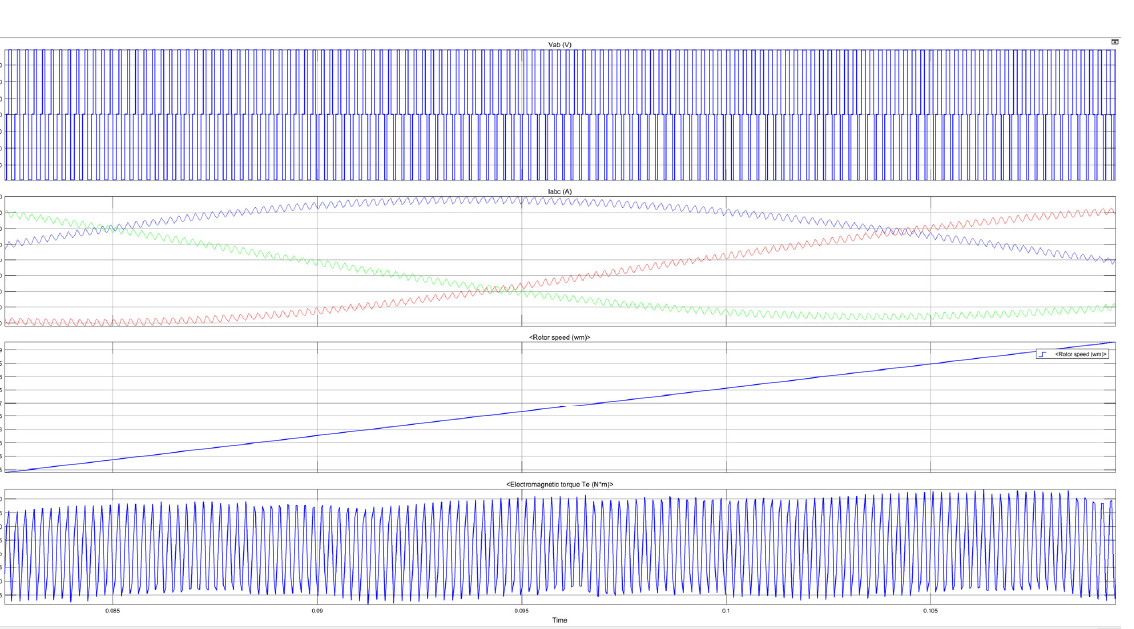
Table 1. Parameters of the induction motor.